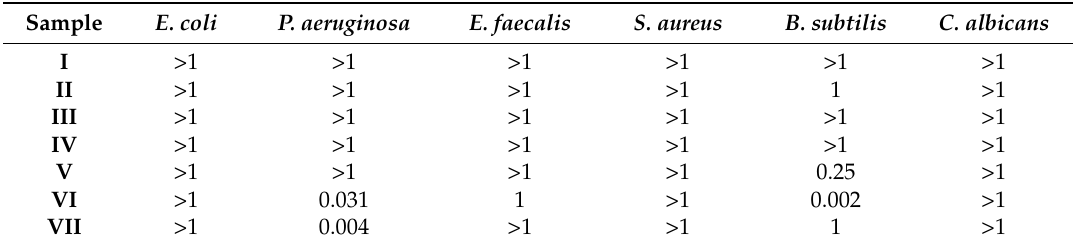
Table 1. Minimal inhibitory concentration (MIC) values of the tested compounds against the tested microbial